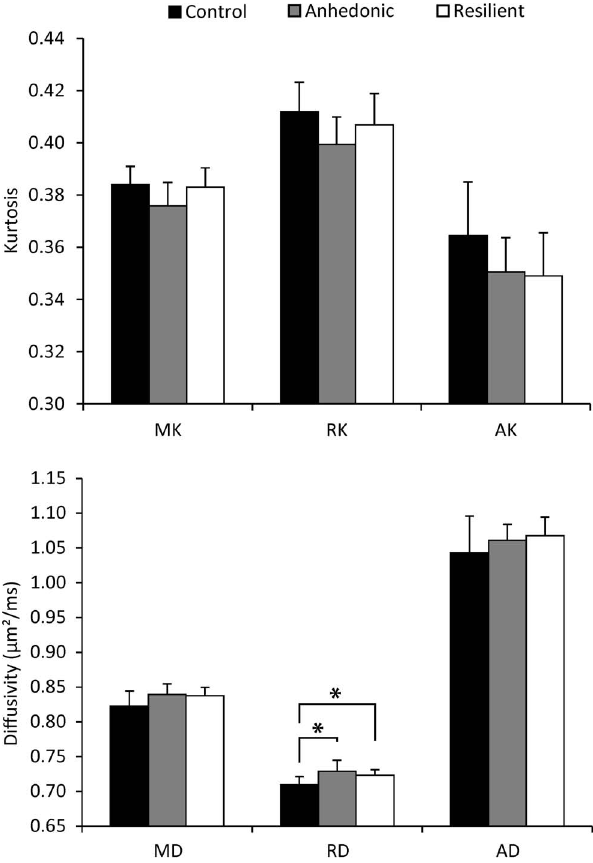
Figure 3. Results of the diffusion analysis of the caudate putamen. Mean ( 6 SD) diffusion kurtosis (top) and diffusivity (bottom) parameters of the caudate putamen. One-way analysis of variance followed by post hoc least significant difference tests showed a significant increase of AD in both the anhedonic-like and resilient animals as compared with the unchallenged group. In addition, MK is significantly decreased in anhedonic-like animals as compared with resilient animals. *p , .05 AD, Axial diffusion; AK, axial kurtosis; MD, mean diffusion; MK, mean kurtosis; RD, radial diffusion; RK, radial kurtosis.